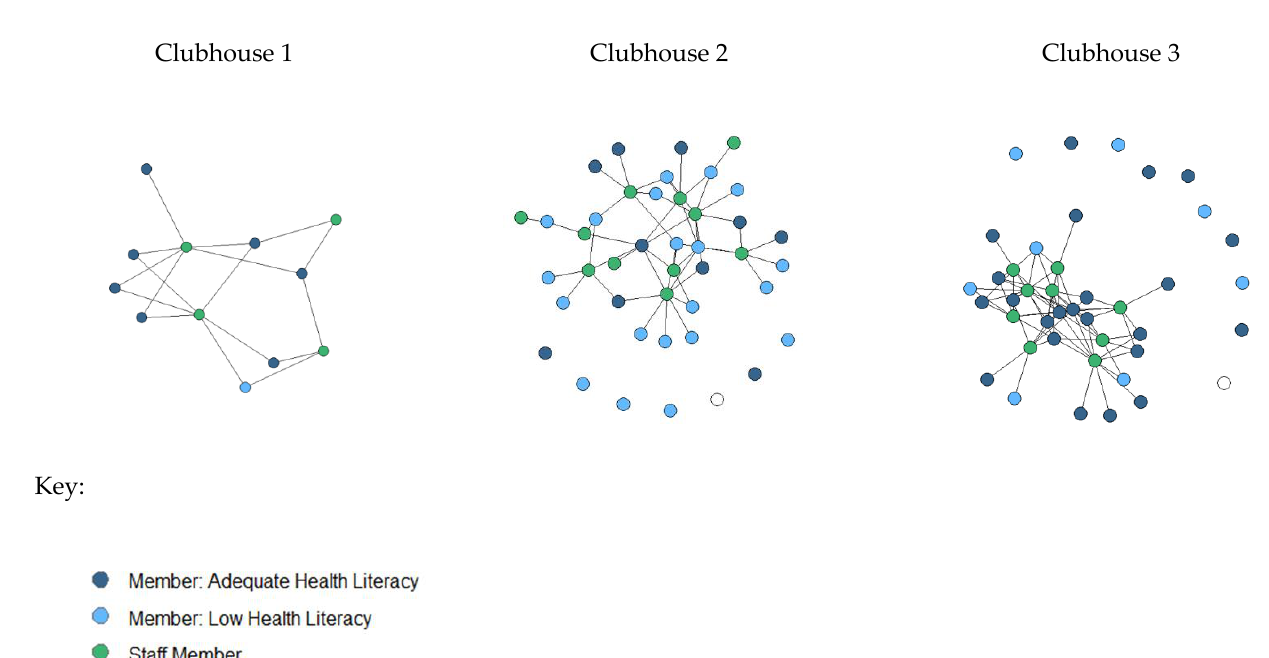
Figure 1. Visualization of Member-Staff Health Discussion Partner Social Networks and Health Lit- eracy.